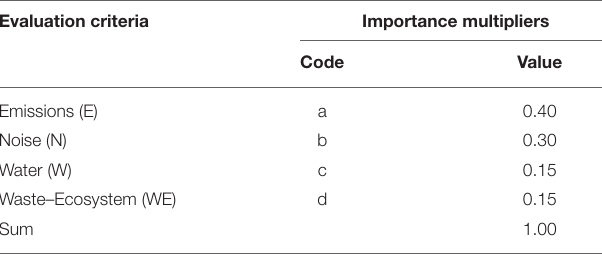
TABLE 2 | Evaluation criteria importance